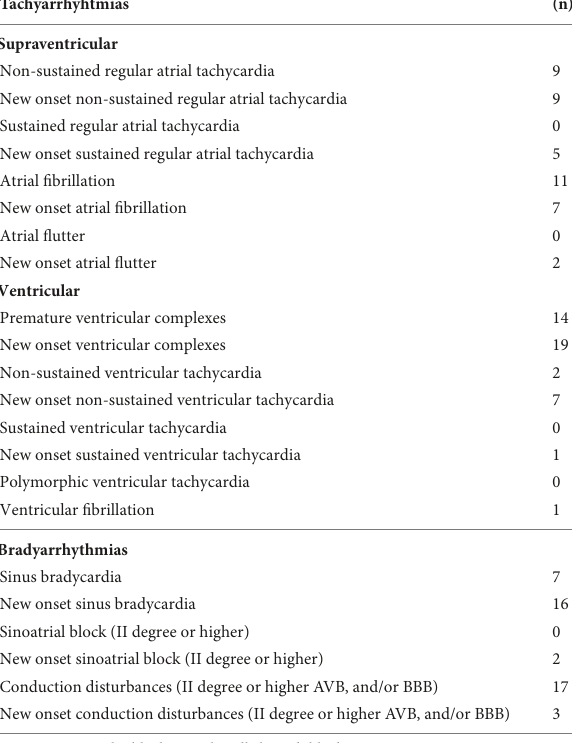
TABLE 2 Type of arrhythmia recorded on cardiac telemetry during in-hospital period.